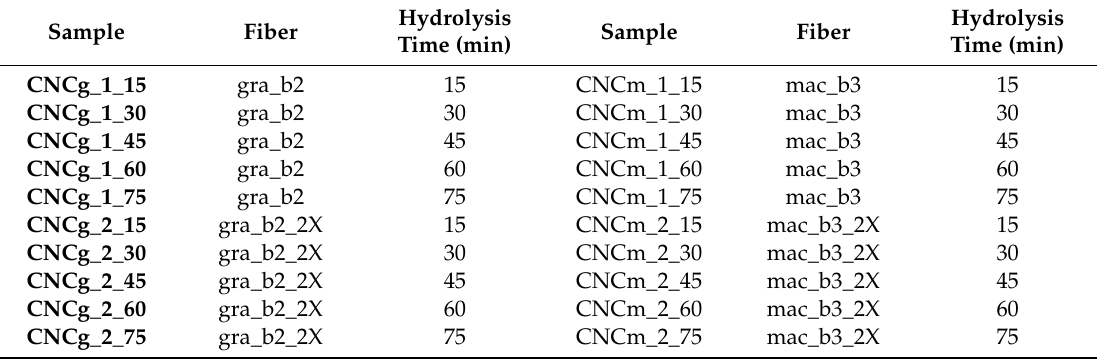
Table 2. CNC samples obtained from gravata and macauba, under di ff erent times of acid hydrolysis at 45 ◦ C and from the once or twice bleached